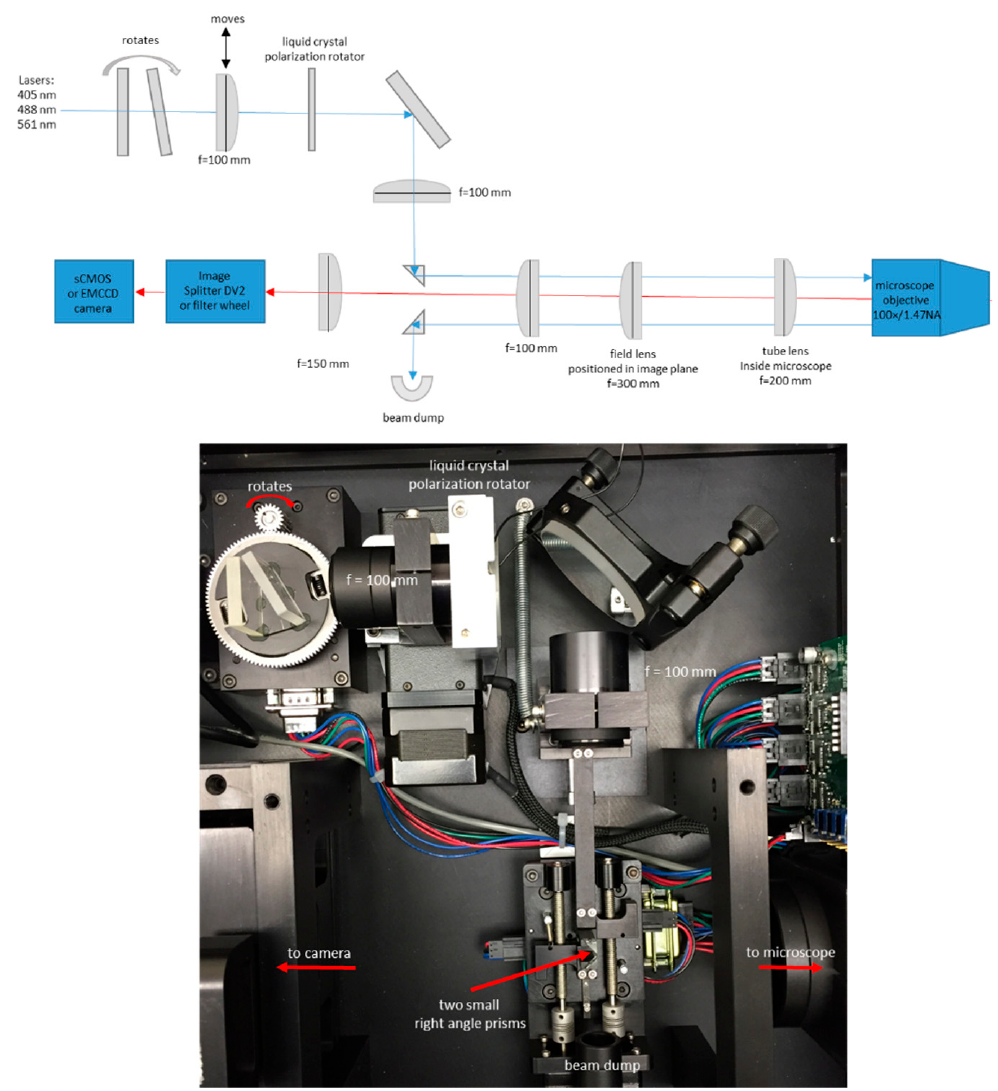
Figure 1. Setup of total internal reflection fluorescence microscope with polarized excitation. Diagram and photograph. Diagram not to scale. Use of small (~2 mm) right-angle prisms [29] to steer the laser beam removes the need for dichroic mirrors. The moving lens and prisms are stepper-motor actuated under computer control and allow precise adjustment of the beam position, and thus of the penetration depth of the evanescent